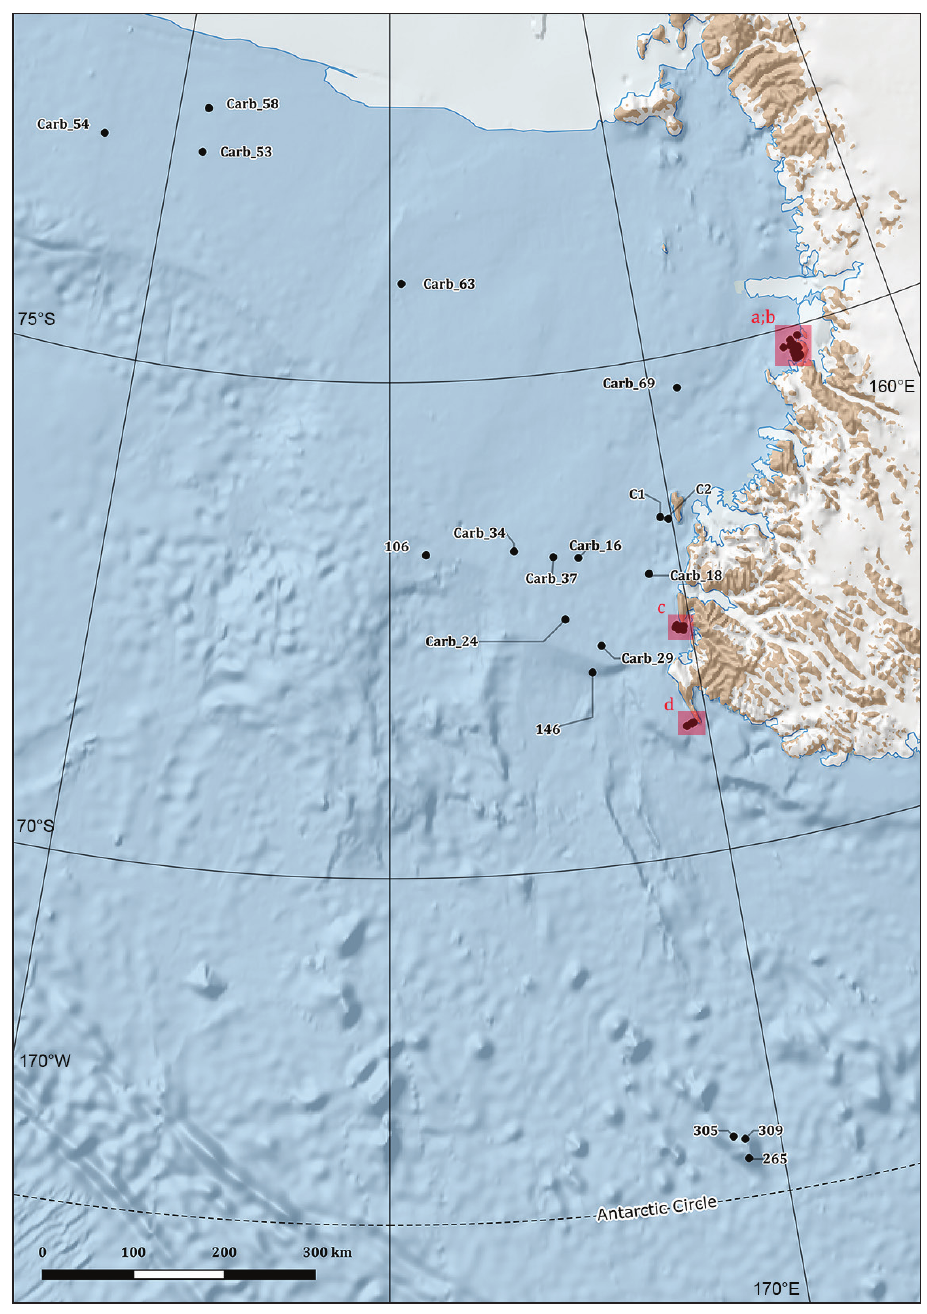
Figure 3. Map of the Ross Sea sampling